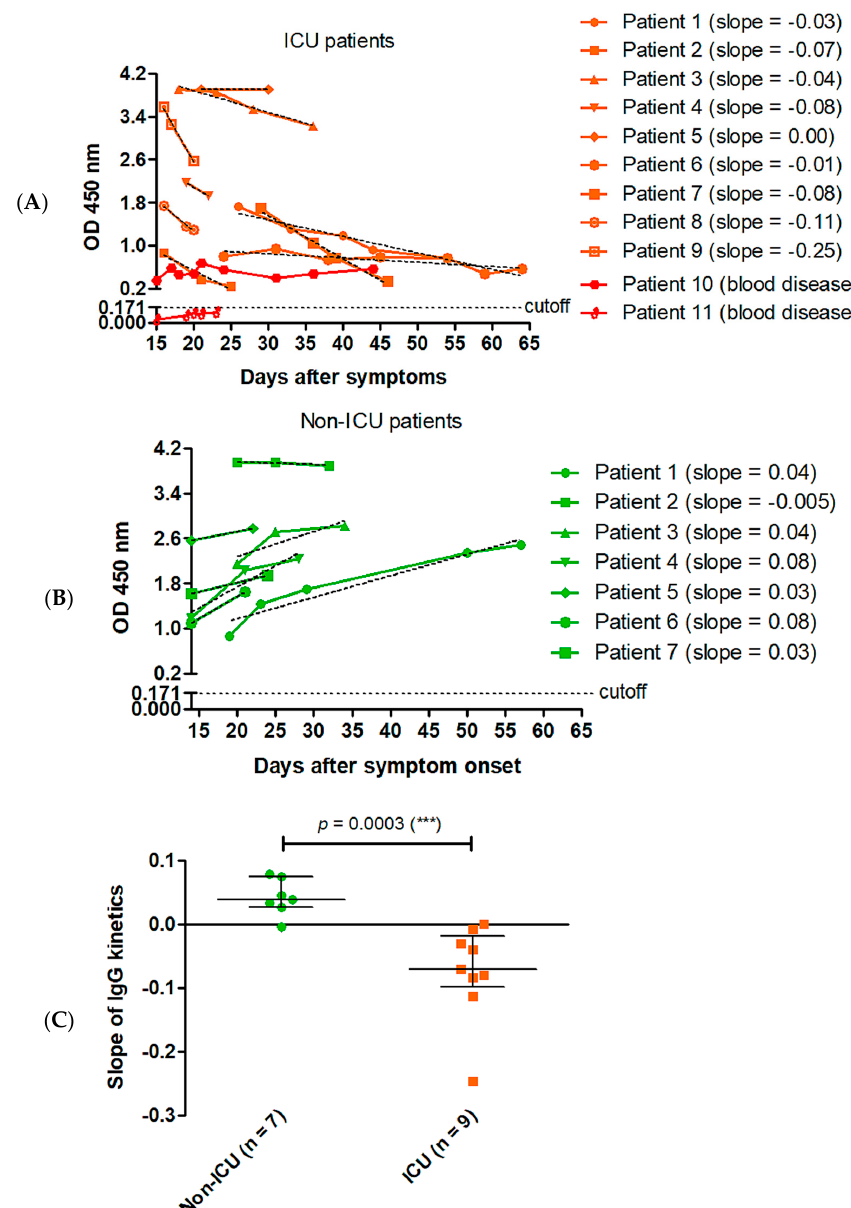
Figure 2. Kinetics of IgG response to SARS-CoV-2 in intensive care unit (ICU) ( n = 11) and non-ICU patients ( n = 7) hospitalized for at least two weeks. ( A ) By using the in-house cell-based ELISA, the kinetics of IgG response was studied in ICU cases, from day 15 after symptom onset. Patients 1 to 9 had no medical history of hematological malignancies. Patient 10 was affected by a chronic lymphocytic leukemia and patient 11 by Waldenström macroglobulinemia. Regression linear curves (dotted black lines) and calculated slopes are represented. ( B ) A similar analysis was performed in non-ICU cases. ( C ) Slopes of linear regression curves for both groups were compared. Median, interquartile range (IQR), and p -value are represented.